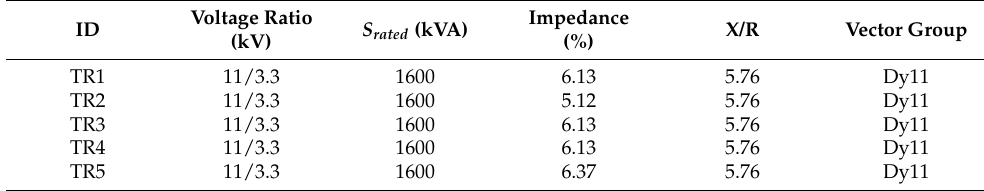
Table A2. Distribution Transformer